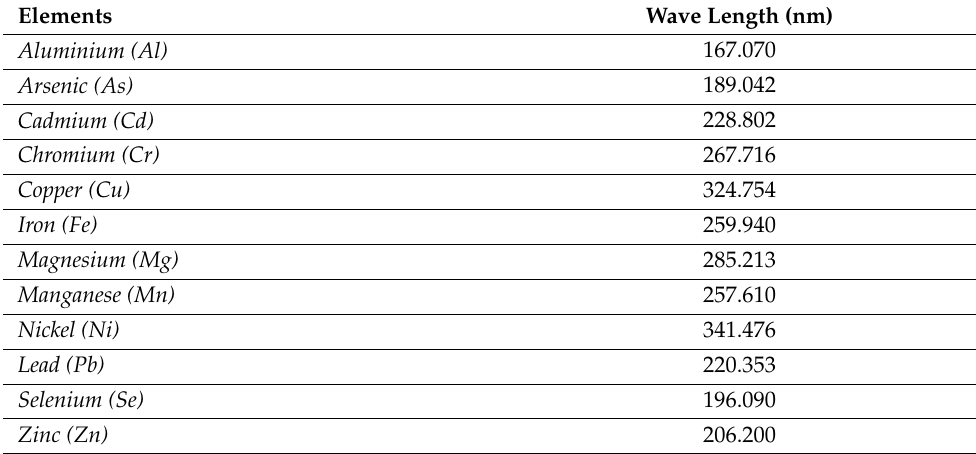
Table 2. Wave lengths used in the analysis for each